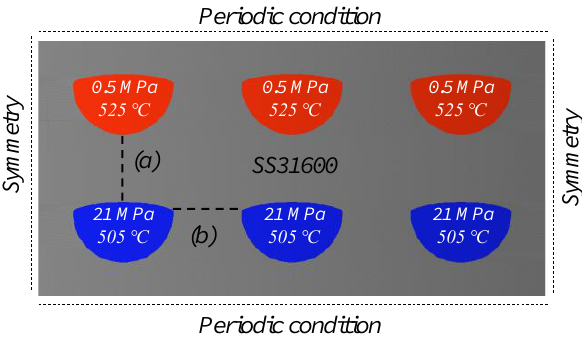
Figure 5. Applied boundary condition for a simulation study.